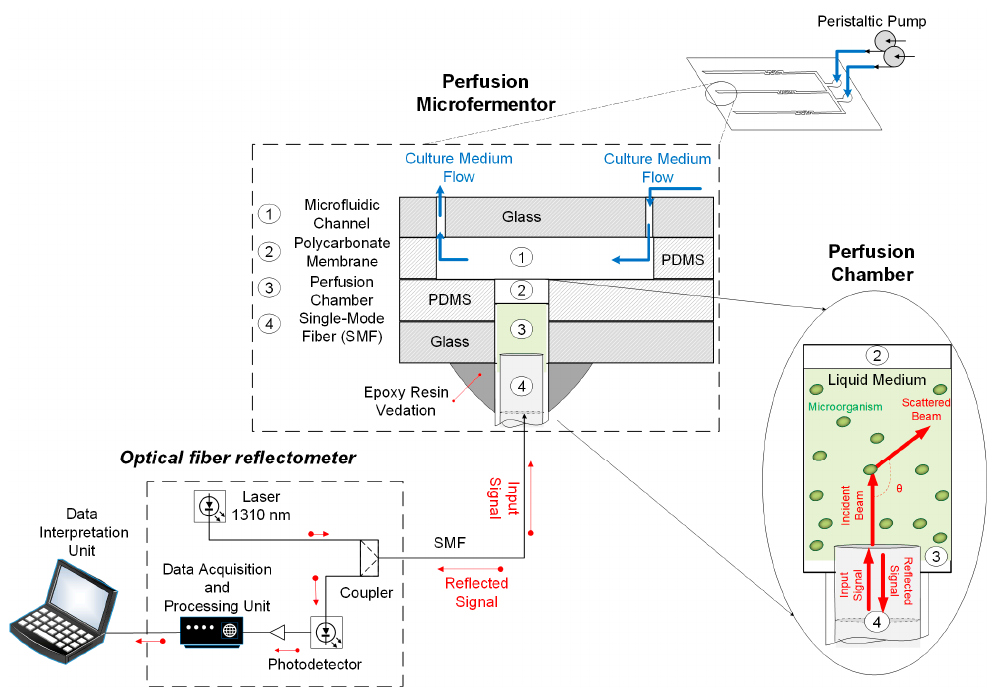
Figure 2. Schematic representation of the instrumented microfermentor. A peristaltic pump flows culture medium through the microchannels of the PDMS top layer and silica single-mode fibers (SMFs) are inserted inside the perfusion chambers, where cells scatter the light (1310 nm laser).